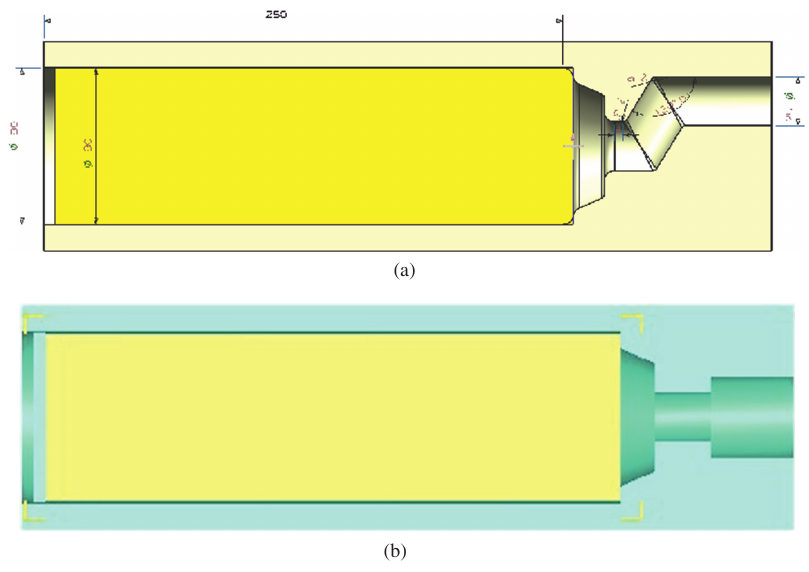
Figure 1: Schematic diagrams of longitudi- nal section (unit: mm): (a) ES die structure and (b) direct extrusion